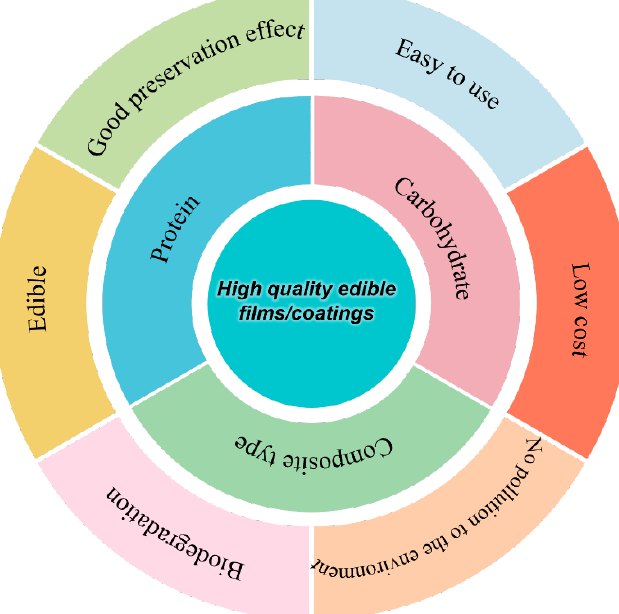
Figure 10. Characteristics of gelatin edible packaging films/coatings for high quality.